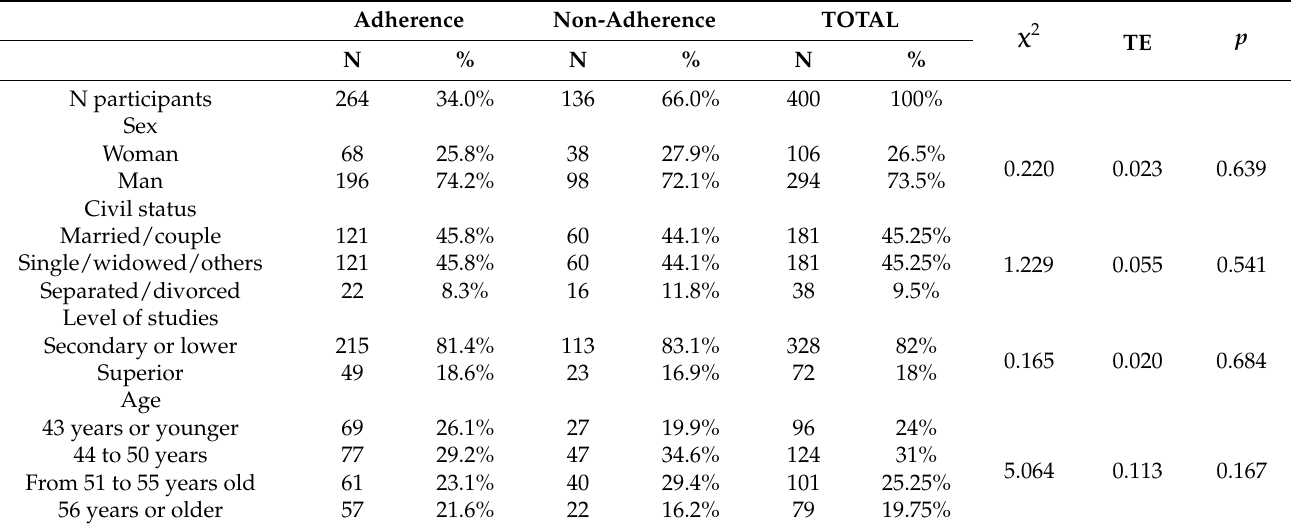
Table 2. Sociodemographic variables according to